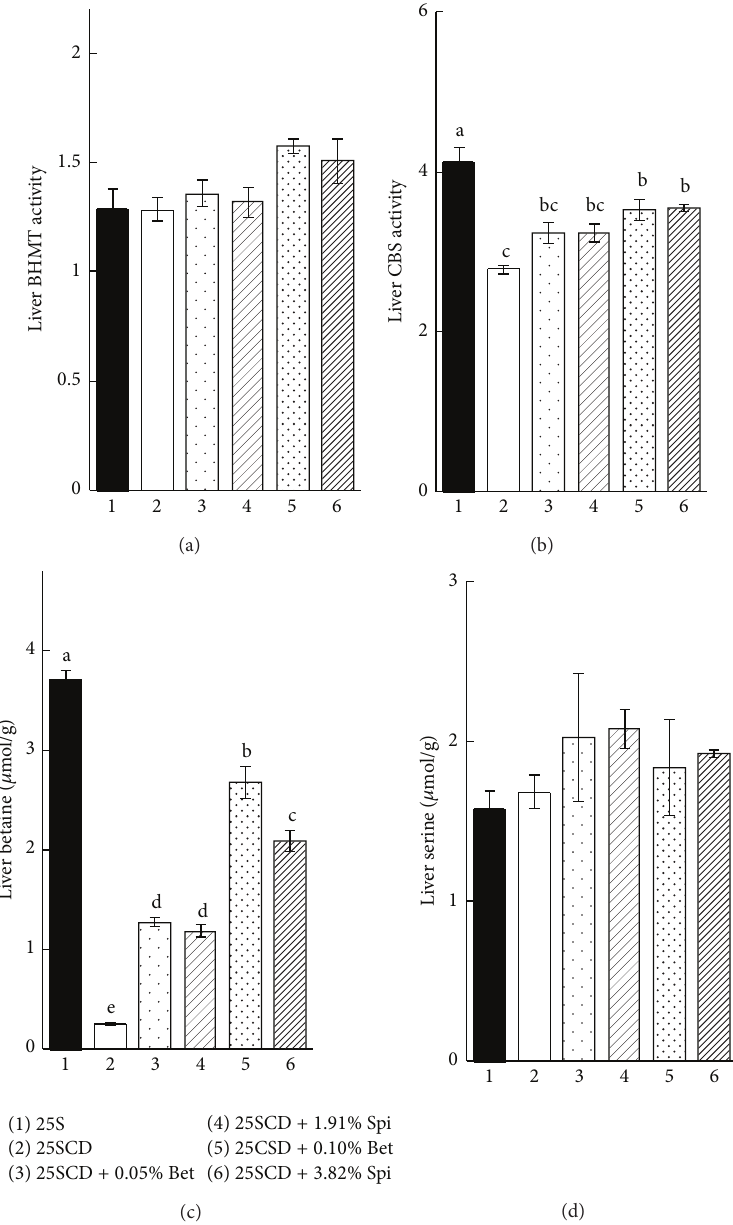
Figure 7: Activities of betaine-homocysteine S-methyltransferase (a) and cystathionine 𝛽 -synthase (b) and concentrations of betaine (c) and serine (d) in the liver of rats fed the experimental diets (experiment 2). Each value is the mean ± SEM, 𝑛 = 6 . Values in a panel without a common letter differ at 𝑃 < 0.05 . Enzyme activities are expressed in nmol/(min ⋅ mg protein).